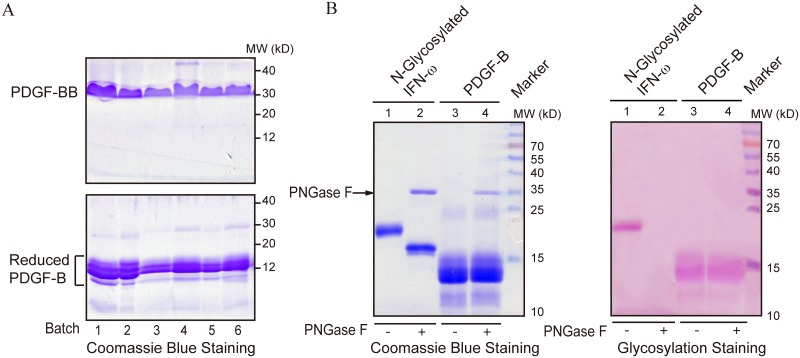
Heterogeneous expression of glycosylated recombinant human PDGF-BB in Pichia pastoris.(A) Purified rhPDGF-BB proteins from six independent expression and purification experiments were analyzed by SDS-PAGE. Heterogeneous rhPDGF-BB bands could be observed under reducing conditions. (B) Purified rhPDGF-BB and rhIFN-ω produced by P. pastoris were treated with PNGase F to hydrolyze N-glycan residues. Two gels loaded with the same amount of each protein (5 μg) were simultaneously subjected to SDS-PAGE, and analyzed by Coomassie Blue staining (left panel) and glycosylation staining (right panel), respectively. There were no differences between rhPDGF-BB samples treated or not with PNGase F.